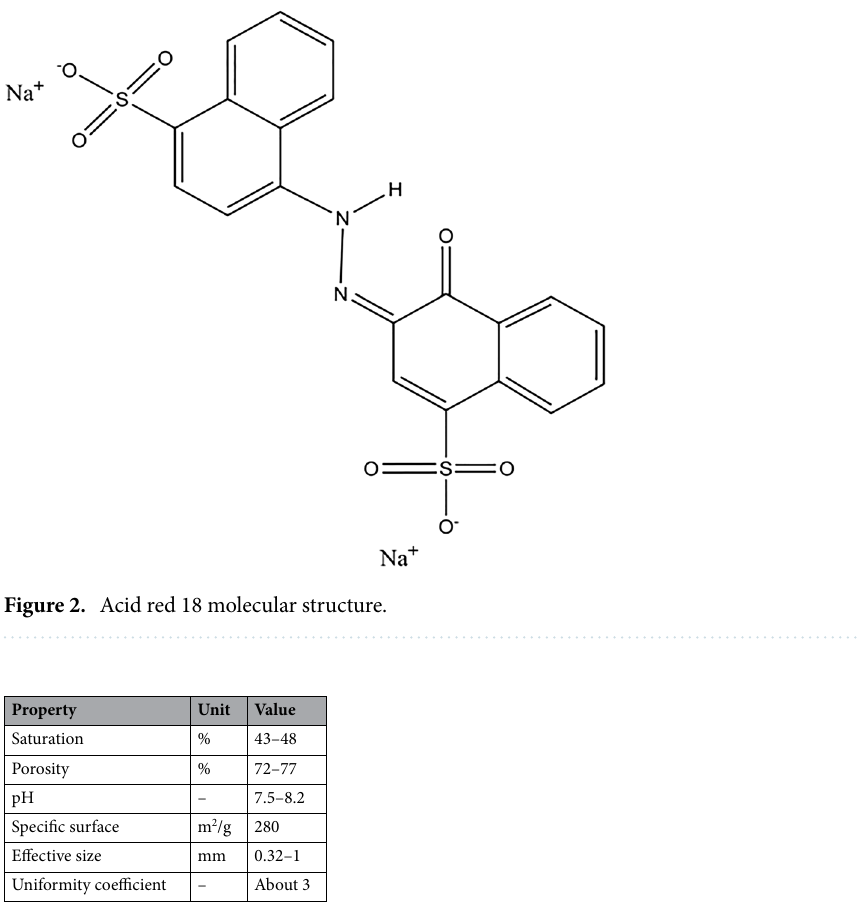
Table 1. GFH properties.